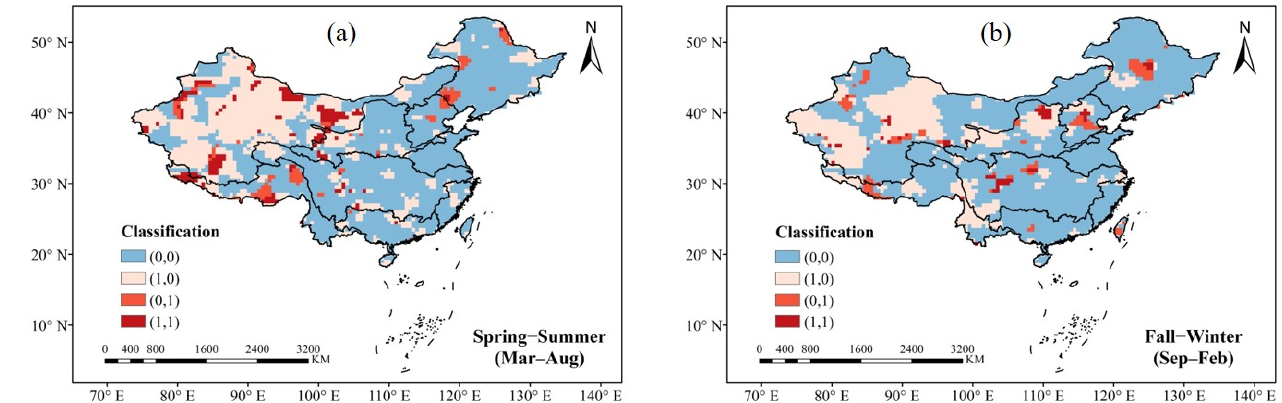
Figure 4. Changes in location and scale ( µ , σ ) parameters for the nonstationary model. 1 indicates a trend that passes the 95% confidence test, and 0 indicates either no trend or one that does not pass the 95% confidence level. ( a ) distribution parameter change class in spring–summer season; ( b ) distribution parameter change class in fall–winter season.